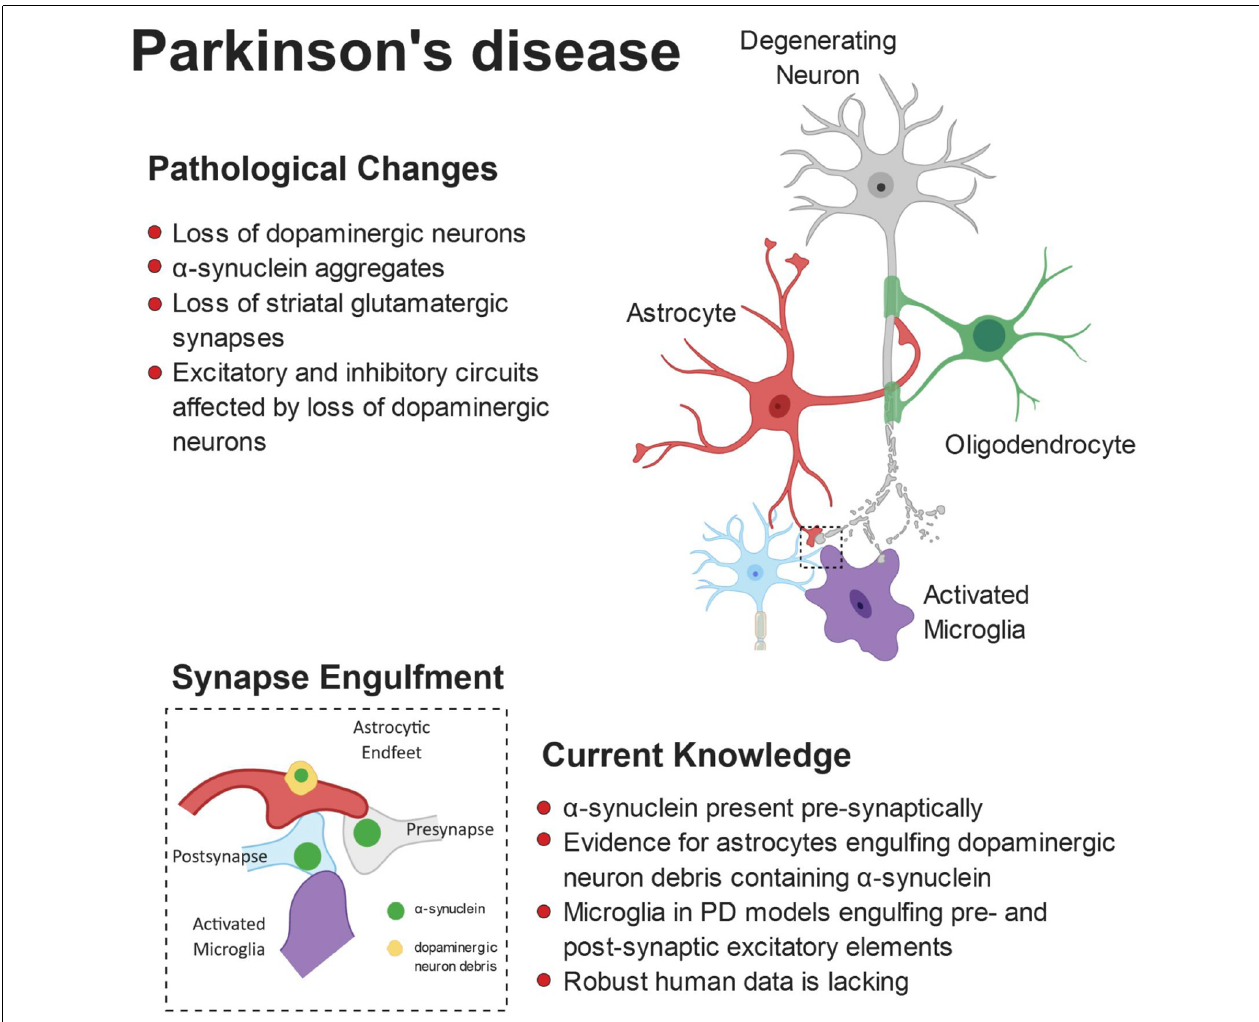
FIGURE 3 | Pathophysiology of Parkinson’s disease (PD). Anatomically, PD is characterized by a loss of striatal dopaminergic neurons. This can lead to disruption of excitatory and inhibitory circuits, resulting in the clinical motor symptoms. Loss of glutamatergic synapses is apparent in the striatum and aggregates of α -synuclein ( α -syn) are observed in the brains of patients. Furthermore, evidence suggests α -syn accumulates at the synapse, where both astrocytes and microglia have been shown to engulf α -syn-containing synaptic